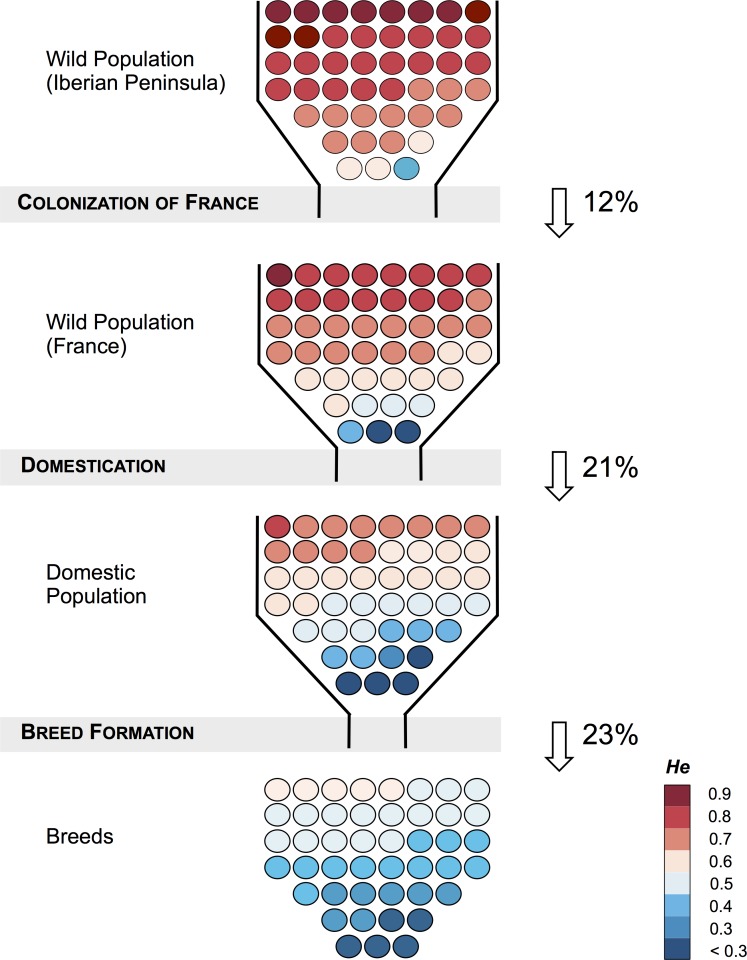
Reduction of genetic diversity along the rabbit domestication route.Each of the 45 circles represents a single microsatellite coloured according to the proportion of the expected heterozygosity per microsatellite present on its respective population. Note that the two wild samples (Iberian Peninsula and France) are proxies for the ancient wild samples that were involved in colonization of France and domestication. Shaded areas indicate the different bottleneck events that occurred at the colonization of France, initial domestication event, and breed formation. Values aside arrows show the amount of genetic diversity lost in each event estimated using a resampling methodology (See Methods).